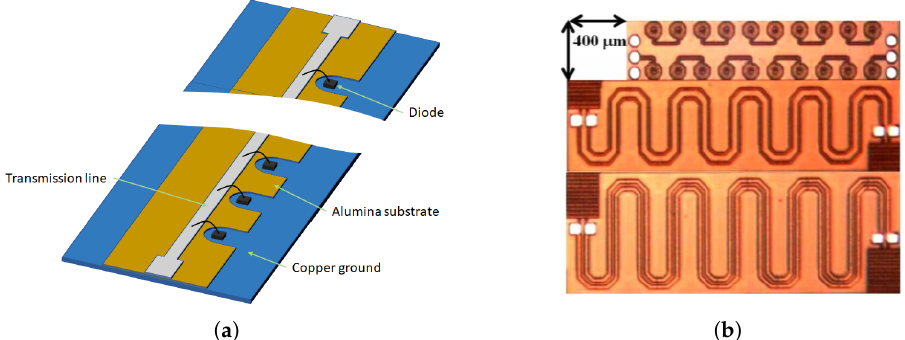
Figure 6. ( a ) Example of nonlinear transmission line (NLTL): ( a ) Discrete diode with co-planar waveguide (CPW) line [54]. ( b ) Discrete inductors and diodes shown at the top [38] [Reproduced with permission from F. Yu, A novel passive RFID transponder using harmonic generation of nonlinear transmission lines; published by IEEE,